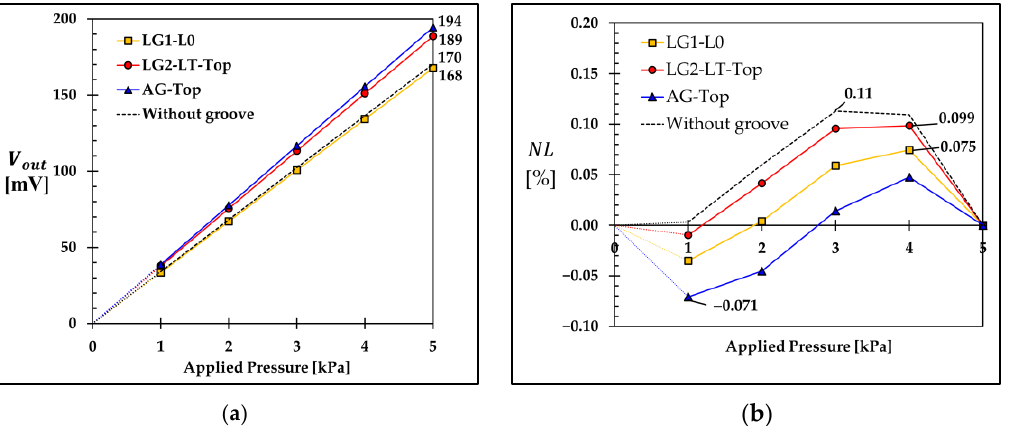
Figure 19. Variations of ( a ) output voltage and ( b ) nonlinearity error with the applied pressures of 1 – 5 kPa of sensors with three optimal groove designs ( 𝐿𝐺1 − 𝐿0 with 𝑑 𝑔 ̅̅̅ = 0.2, 𝐿𝐺2 − 𝐿𝑇 − 𝑇𝑜𝑝 with 𝑑 𝑔 ̅̅̅ = 0.6 and 𝑙 𝑔 ̅ = 0.35 and 𝐴𝐺 − 𝑇𝑜𝑝 with 𝑑 𝑔 ̅̅̅ = 0.2) and without groove.